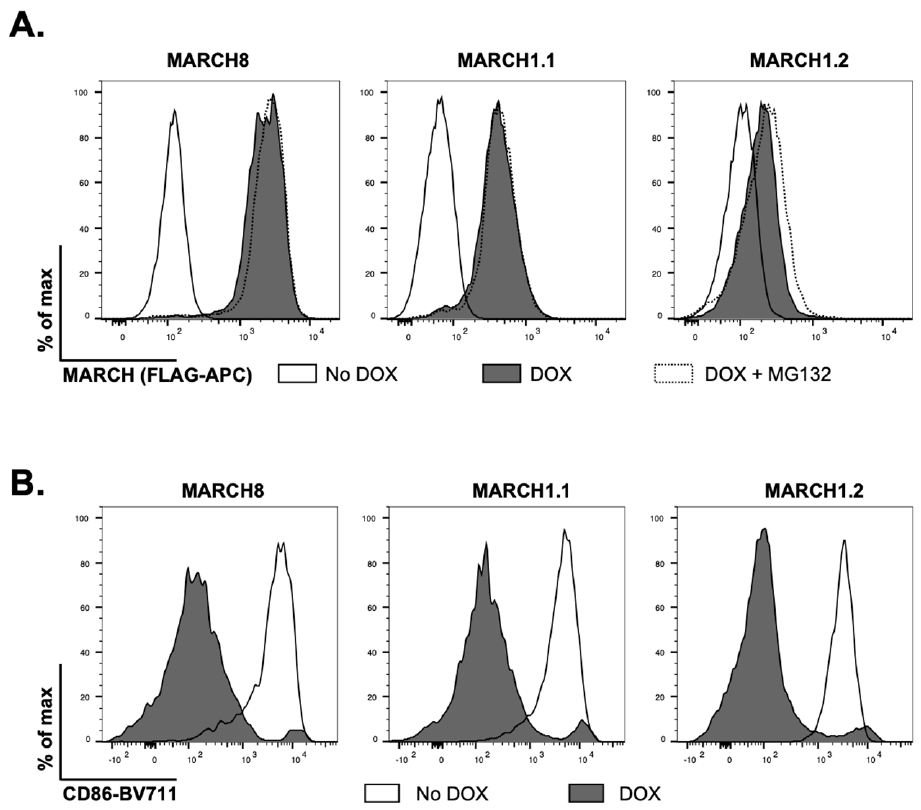
Figure 1. Characterisation of cell lines with inducible expression of MARCH1.1 or MARCH1.2. ( A ) 293T cells with stable DOX-inducible overexpression of FLAG-tagged MARCH1.1, 1.2 or 8 pro- teins were cultured for 24 h in media alone (no DOX) or supplemented with 1 mg/mL DOX (DOX) or in DOX with MG132 added for the last 4 h (DOX + MG132). MARCH protein expression was